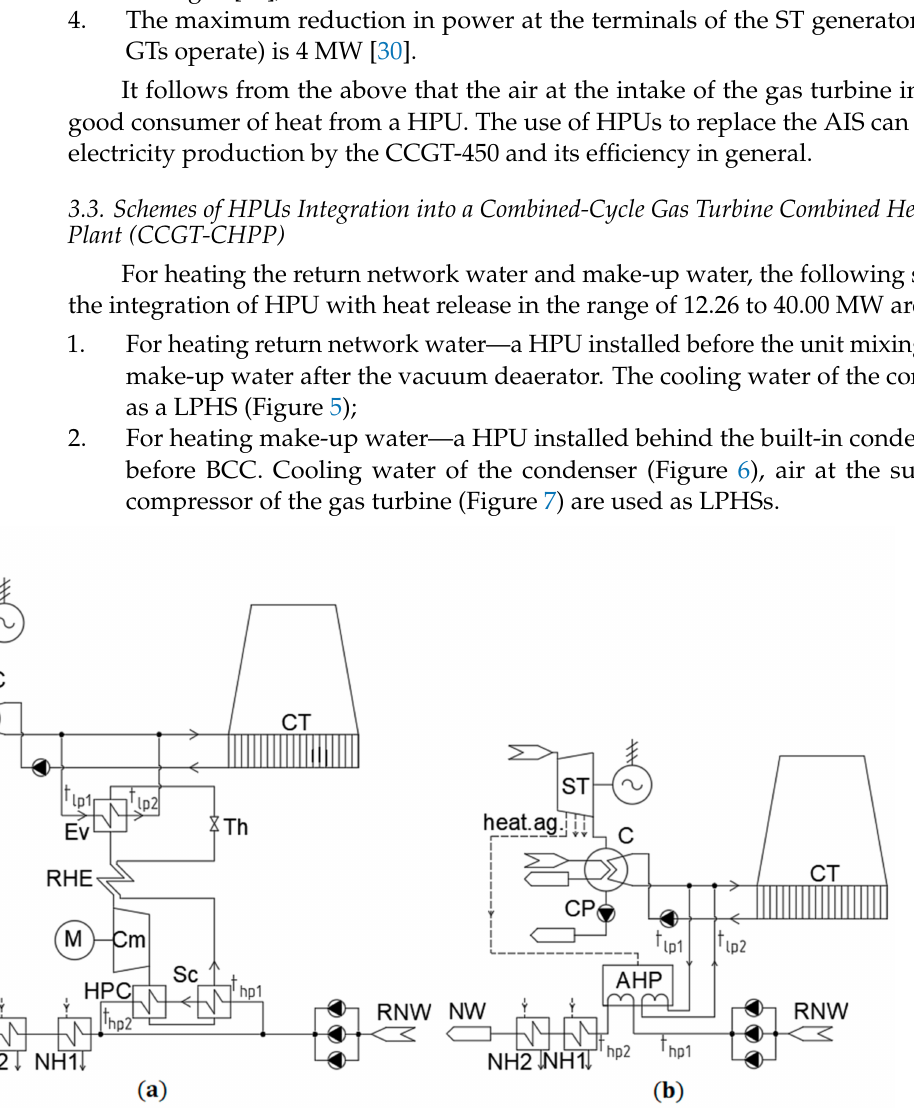
Figure 5. Schemes of integrating vapor-compression heat pump (VCHP) with a regenerative heat exchanger (RHE) and a supercooler (Sc) ( a ), AHP ( b ) for heating RNW. Circulating water as a LPHS. ST—steam turbine; CT—cooling tower of the circulating water supply system, heat.ag.—the heating agent of an AHP generator (extracted steam from a ST); HPC—VCHP condenser, Th—throttle, Cm—compressor, Ev—evaporator; RHE—regenerative heat exchanger; Sc—supercooler. t lp1